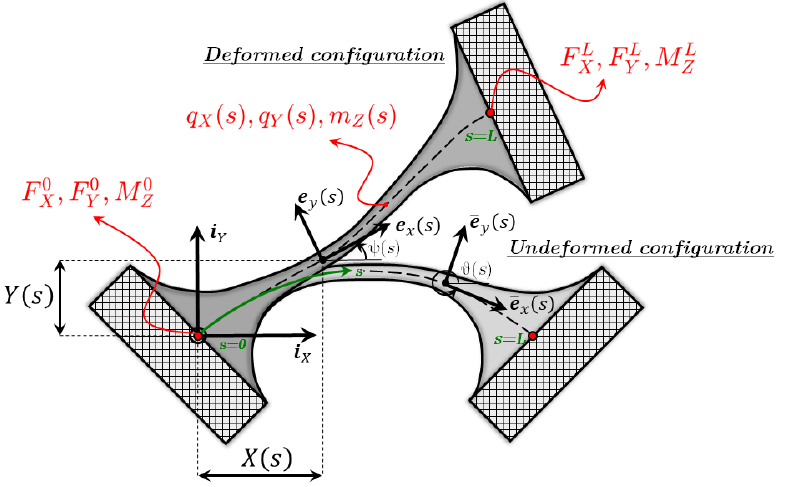
Figure 2. Generic undeformed and deformed configurations.